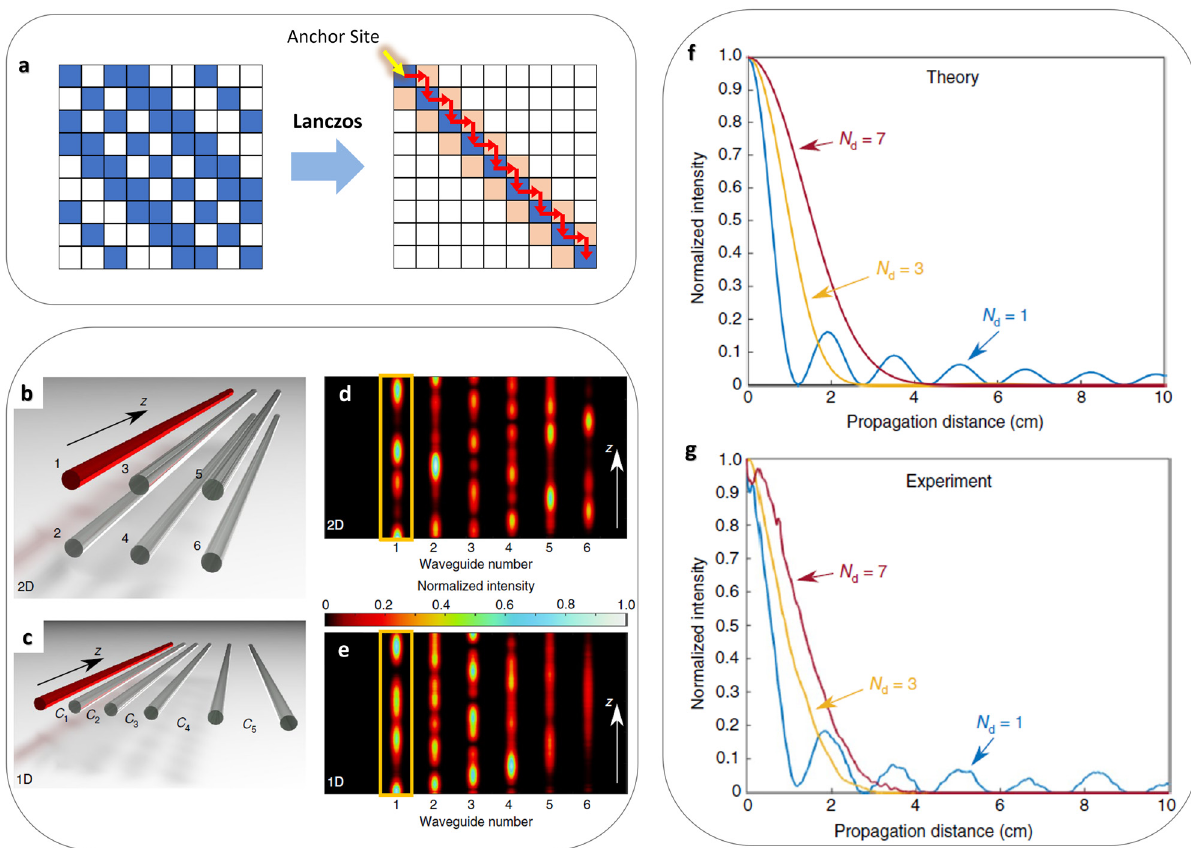
Figure 7: Isospectrality using Lanczos transformation. (a) A schematic of Lanczos-based tridiagonalization from initial 2D to final 1D Hamiltonian matrices [86]. Blue and white represent off-diagonal components and zero in the matrices. Reddish boxes denote the calculated fi rst off-diagonal elements. The yellow arrow depicts the anchor site, and red arrows describetherecursivecalculation procedure of Lanczos tridiagonalization. (band c) The structures connected through theLanczos transformation [83]: (b) original 2D and (c) transformed 1D coupled waveguide arrays. Red waveguides denote the anchor sites. C n represents the nonuniform coupling between waveguides, which results from the Lanczos transformation. (d and e) Experimental veri fi cation of the reproduced excitation dynamics [83] in the (d) 2D and (e) 1D waveguide arrays. (f) Theoretical and (g) experimental observation of excitation dynamics in the anchor sites of the 1D transformed structures, which are obtained from Lanczos-transformed 1D, 3D and 7D hypercubic lattices [83]. Panel (a) is adapted with permission from [86]. Panels (b – g) are adapted with permission from [83], ⓒ Springer Nature